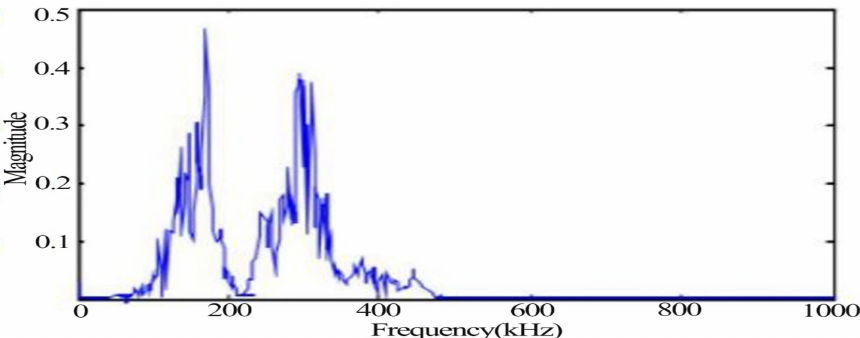
Figure 8. Typical acoustic emission signal spectrum in the yielding